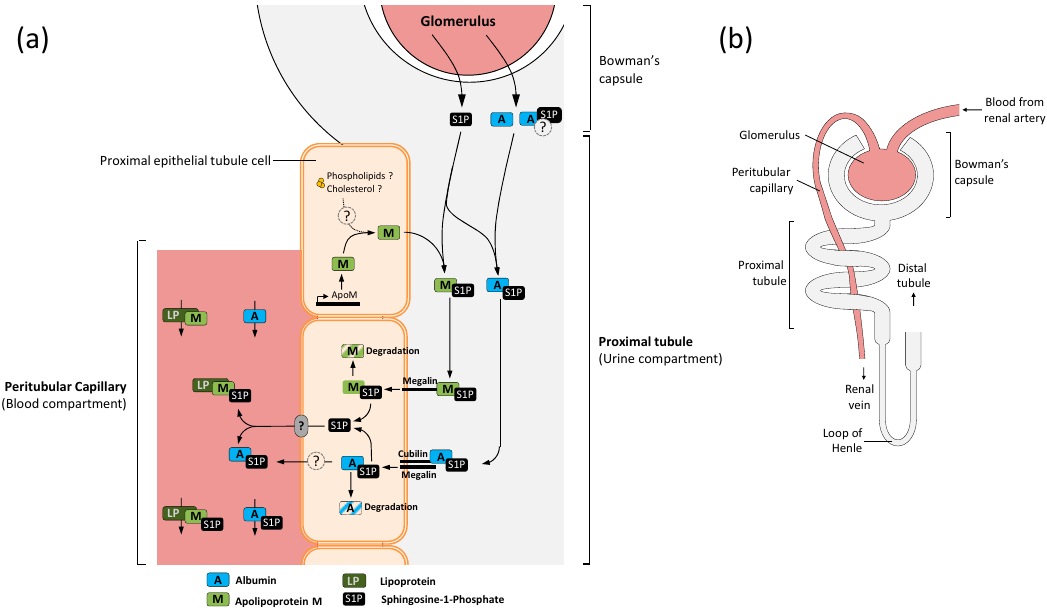
Figure 1. ( a ) Albumin and apoM operate as scavenger proteins in the proximal tubuli of the kidney to recover glomerular filtrated S1P. Whereas apoM is de novo synthesized and secreted by proximal epithelial tubule cells, albumin (probably already loaded with S1P) enters the tubuli through the glomerulus. Upon binding of free S1P, apoM interacts with the megalin receptor and albumin with its co-receptor cubilin, followed by internalization. A fraction of albumin may be further exported to adjacent peritubular capillaries (probably loaded with S1P molecules) whereas another portion undergoes protein degradation associated with release of scavenged S1P. Current evidence suggests that apoM will be rather degraded than exported. ApoM associated lipoproteins and/or albumin from peritubular capillaries further induce the export of accumulated S1P from the proximal tubule epithelium. These proteins are also involved in S1P binding and transportation to other cellular networks. ( b ) Macroscopic representation of the renal tubule system, highlighting the most relevant structures involved in apoM and albumin mediated S1P recovery.